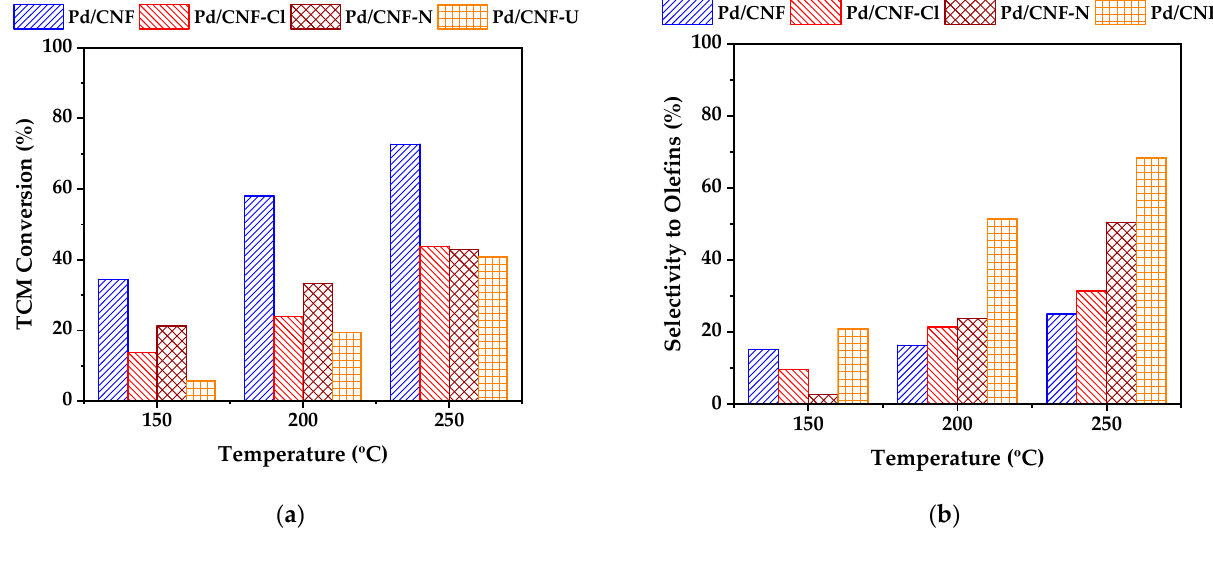
Figure 5. Influence of surface functionalization at different reaction temperature on ( a ) TCM conversion and ( b ) selectivity to olefins (space-time ( τ ) = 0.2 kg h mol − 1 ; H 2 /TCM = 50).